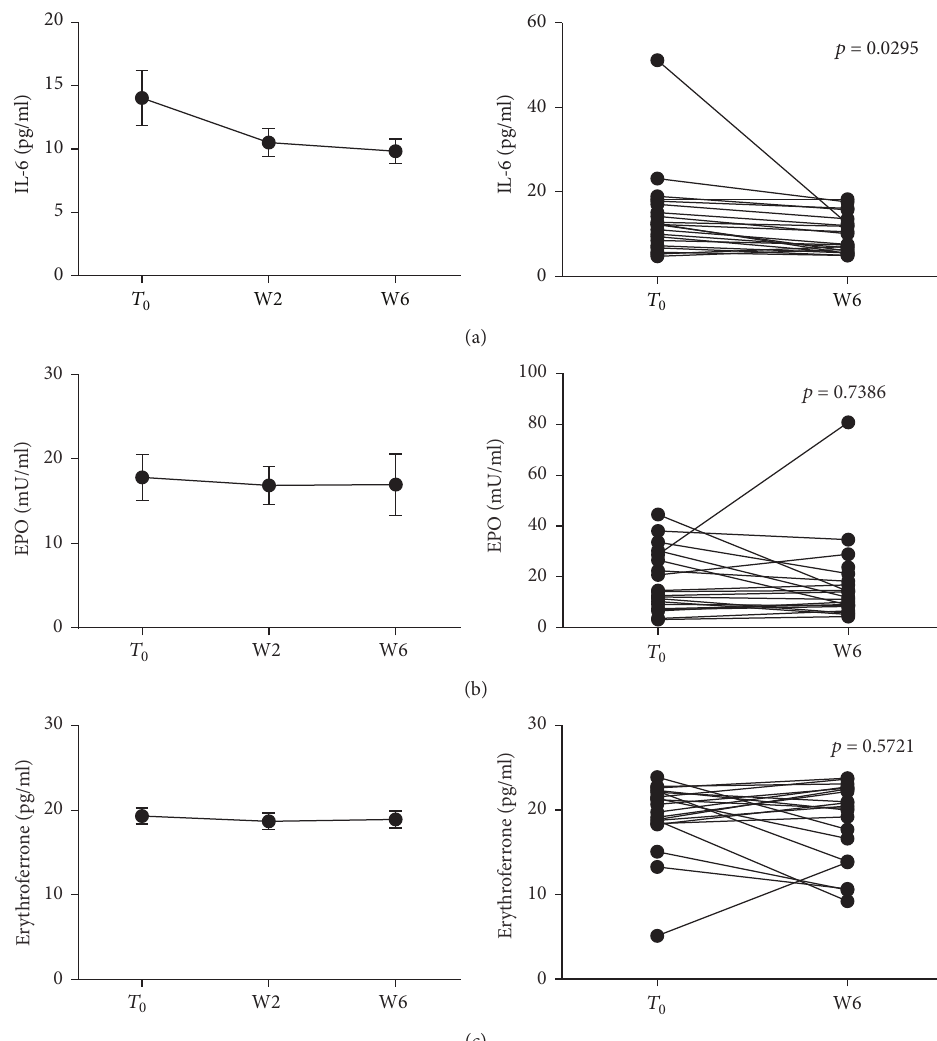
Figure 6: IL-6, EPO, and ERFE levels before and after 6 weeks of anti-TNF therapy. Sera were collected before each anti-TNF administration ( 𝑁 = 21 /time point) and IL-6, EPO, and ERFE levels measured. Statistical analysis was performed using Student’s 𝑡 -test for paired data. Data are presented as single data point or as mean ± SEM.